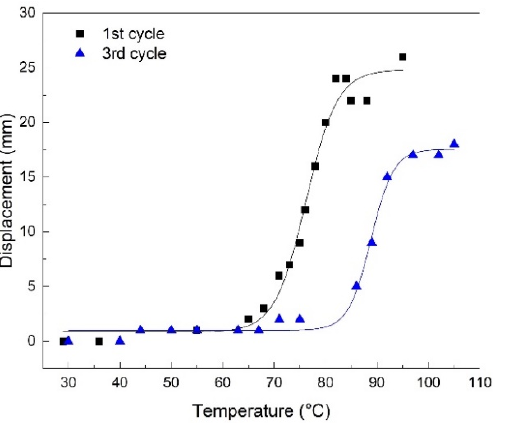
Figure 5. Free end’s displacement vs. temperature during free-recovery SME, according to Figure 4.